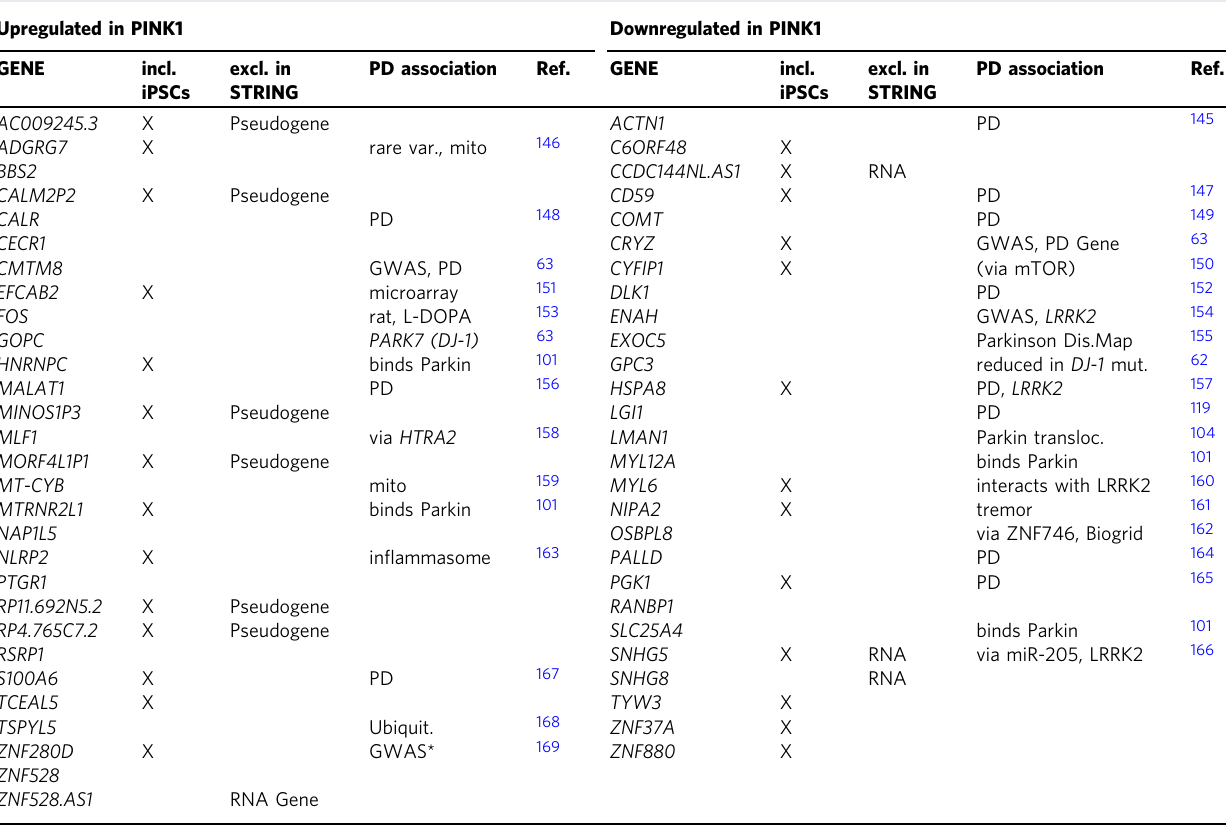
Table 2 The top genes dysregulated consistently in PINK1 vs. control cells across differentiation stages. Upregulated in